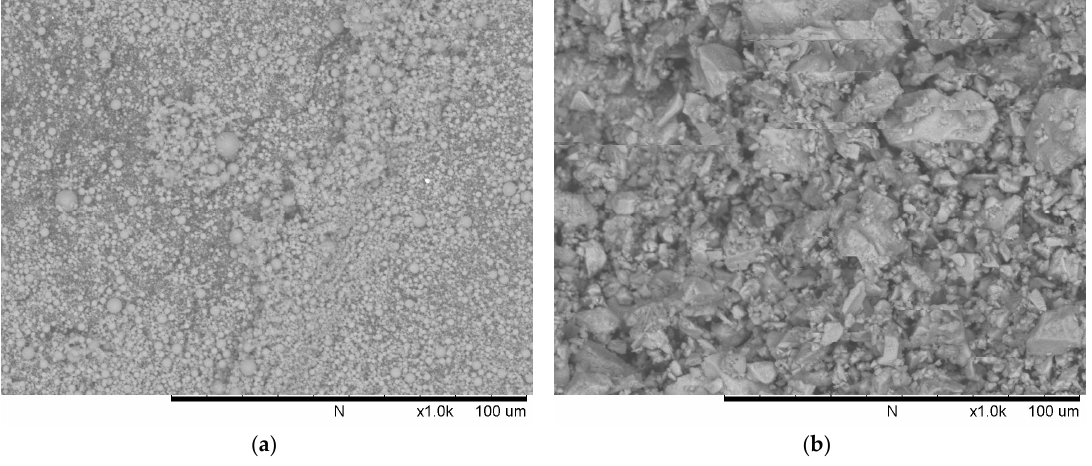
Figure 2. Scanning electron micrographs of: ( a ) fly ash; ( b ) cement. Table 1. Chemical composition of fly ash and cement.